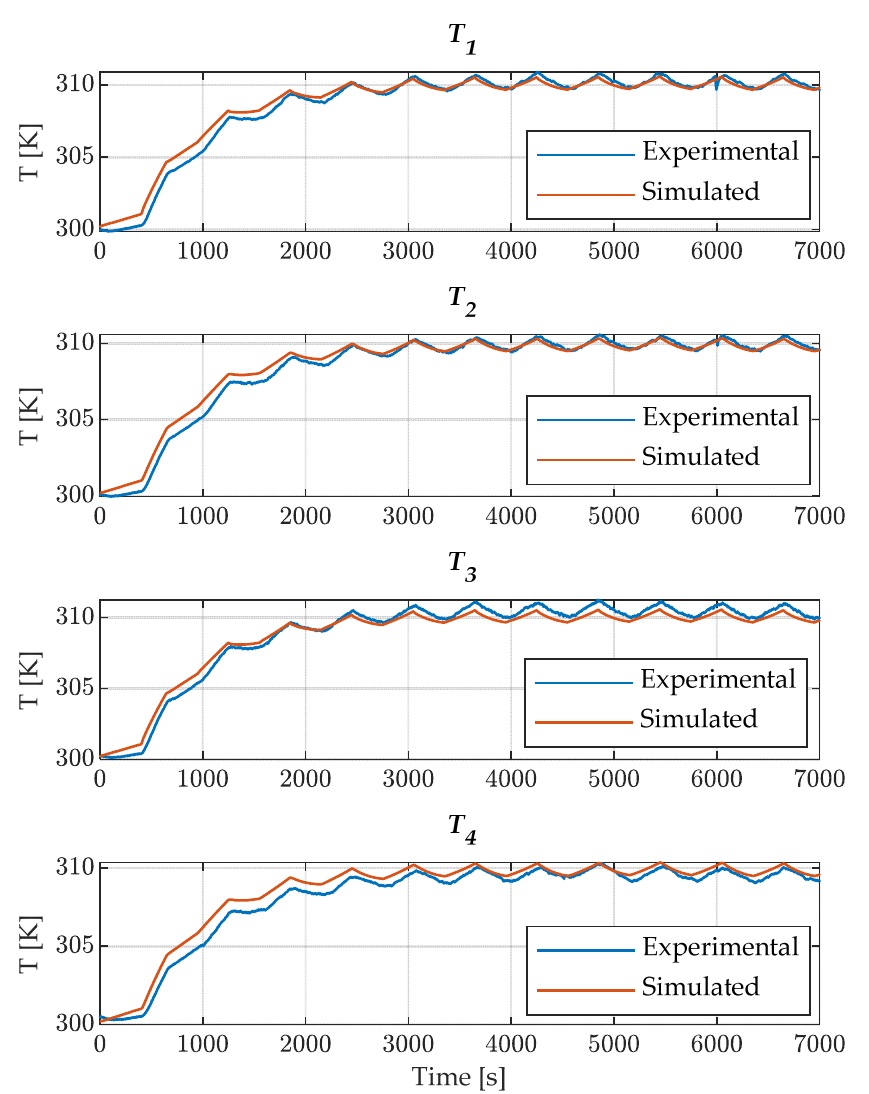
Figure 15. Thermocouples results for the single cell test at 20 A.